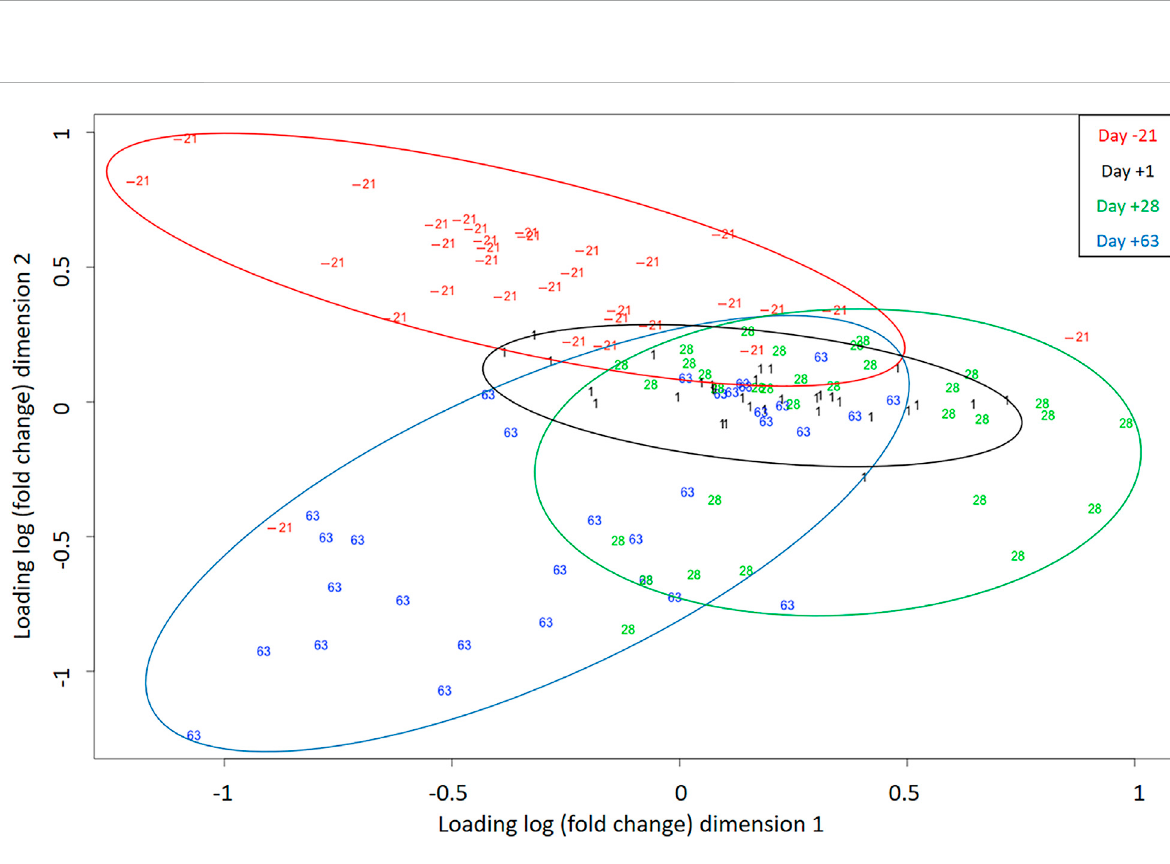
FIGURE 3 Multidimensional scaling (MDS) plot indicates samples (individual sequencing) separation during days -21, 1, 28, and 63 relative to parturition. Different colors correspond to different time